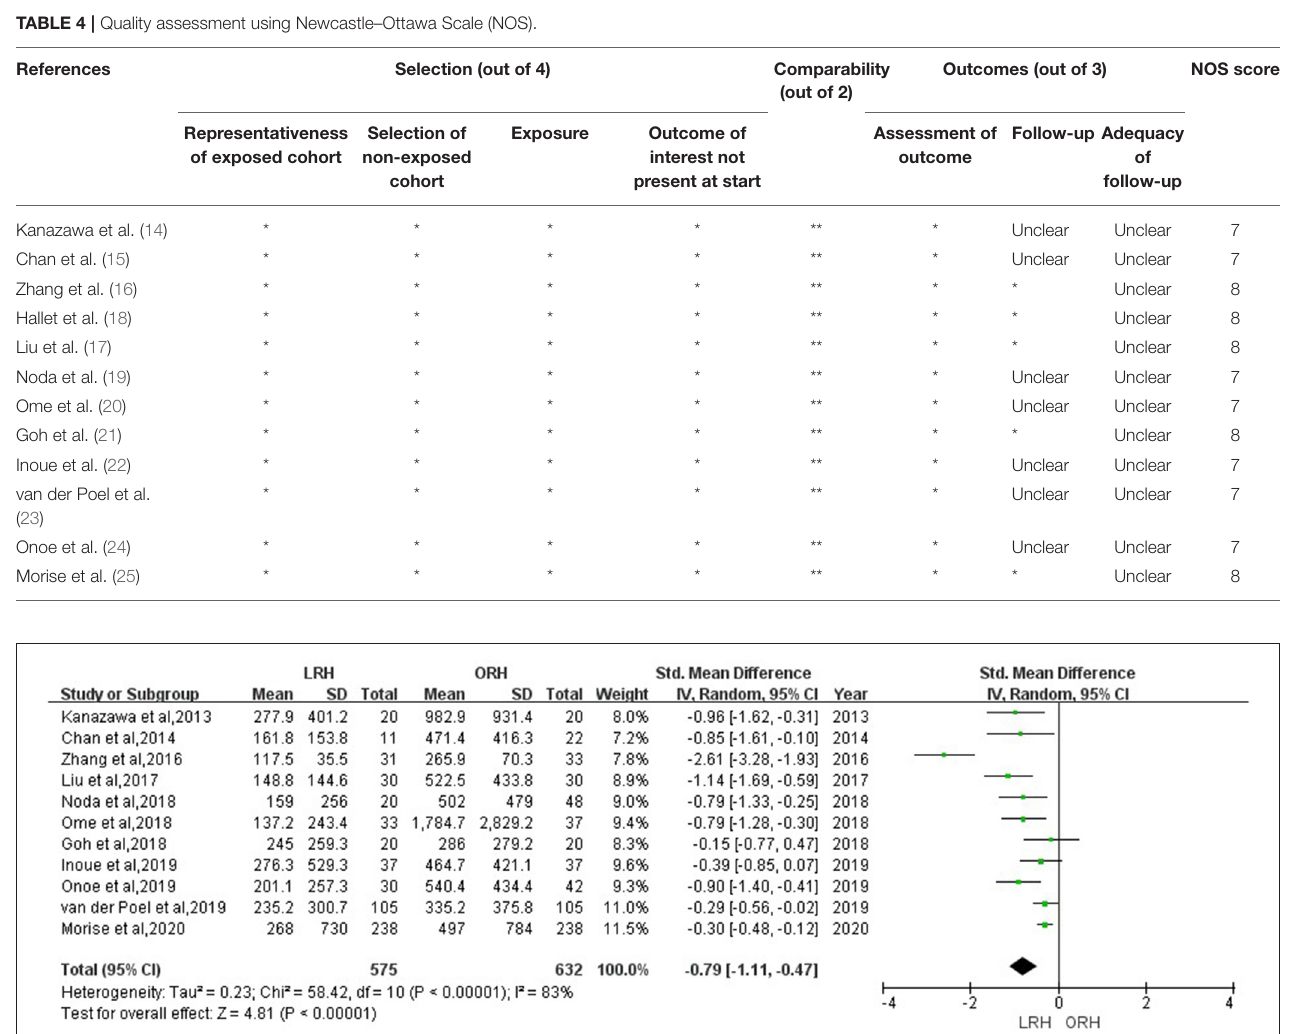
FIGURE 5 | Forest plots comparing blood loss between LRH group and ORH